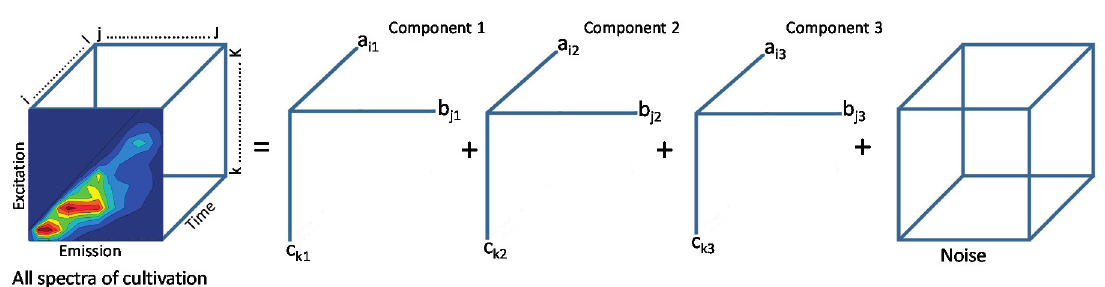
Figure 4. PARAFAC model with three components (F = 3) for the modeling of three process